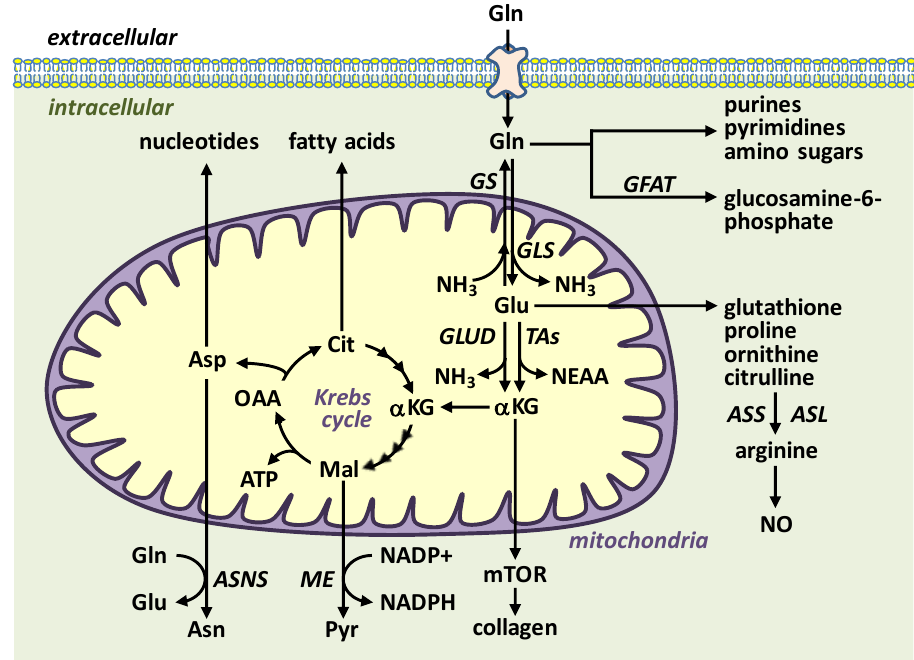
Figure 1. Overview of L -glutamine (Gln) transport and metabolism. Gln is transported into cells by various transporters and preferentially metabolized to L -glutamate (Glu) and ammonia (NH 3 ) by the mitochondrial enzyme glutaminase (GLS). In contrast, the enzyme glutamine synthetase (GS) condenses NH 3 to Glu to form Gln while the enzyme glutamine:fructose-6-phosphate amidotransferase (GFAT) transfers Gln’s amino group to fructose-6-phosphate to generate glucosamine-6-phosphate. Gln and Glu can be converted to a number of important molecules, including amino acids, fatty acids, nucleotides, adenosine triphosphate (ATP), glutathione, and Krebs cycle intermediates. Asn, asparagine; ASNS, asparagine synthetase; Asp, aspartate; ASS, argininosuccinate synthetase; ASL, argininosuccinate lyase; Cit, citrate; GLUD, glutamate dehydrogenase; α KG, α -ketoglutarate; Mal, malate; ME, malic enzyme; mTOR, mammalian target of rapamycin; NEAA, nonessential amino acids; NO, nitric oxide; OAA, oxaloacetate; Pyr, pyruvate; TAs, transaminases.